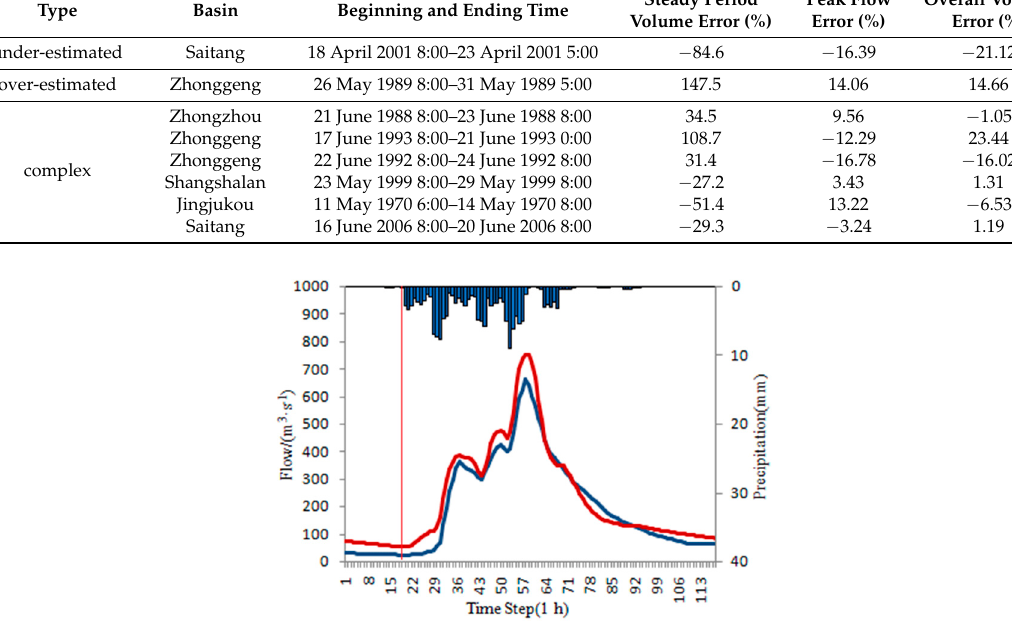
Figure 8. Over-estimated flood. ( A )